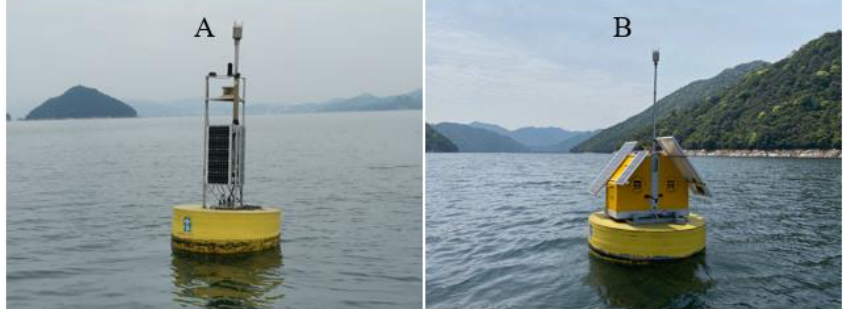
Figure 2. Pictures of ( A ) the Buoy_surface system at site 5, ( B ) the Buoy_profiler at site 4.